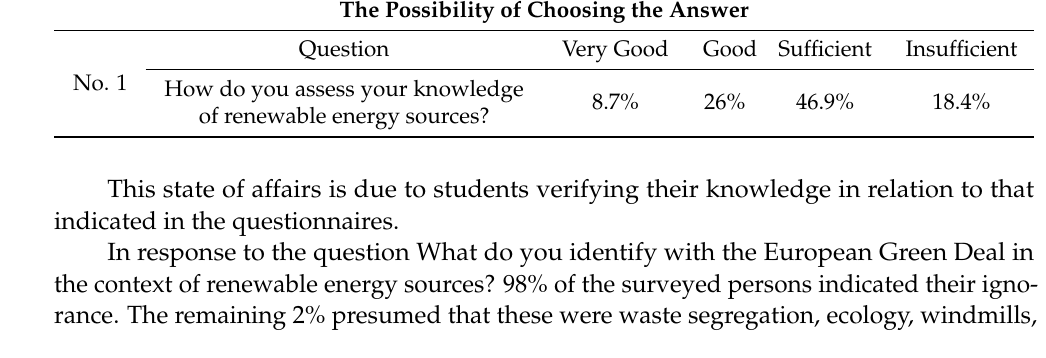
Table 1. Question no. 1, research